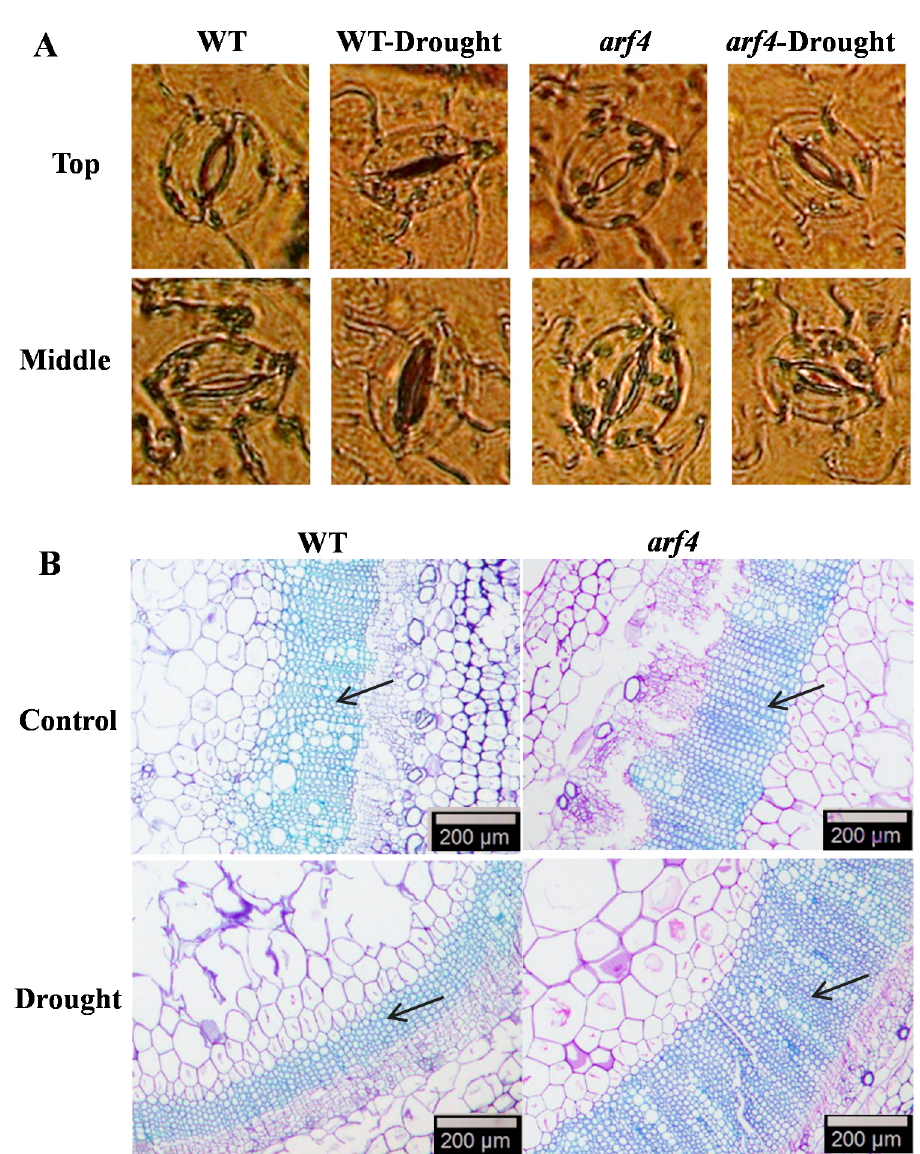
Figure 3. Morphology of stomata on tomato leaf epidermis ( A ) and paraffin section of a 2-month-old tomato stem ( B ). The black arrow represents the xylem. The scale represents 200 μ m.